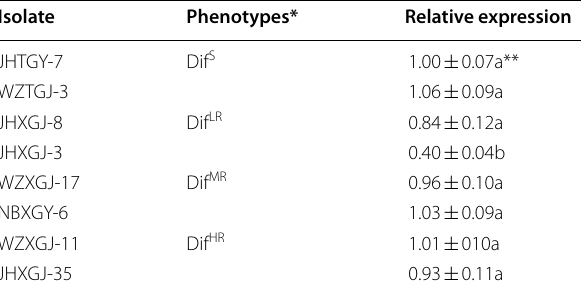
Table 4 Relative expression of the cyp51 gene in the Stagonosporopsis citrulli isolates with varying levels of sensitivities to difenoconazole